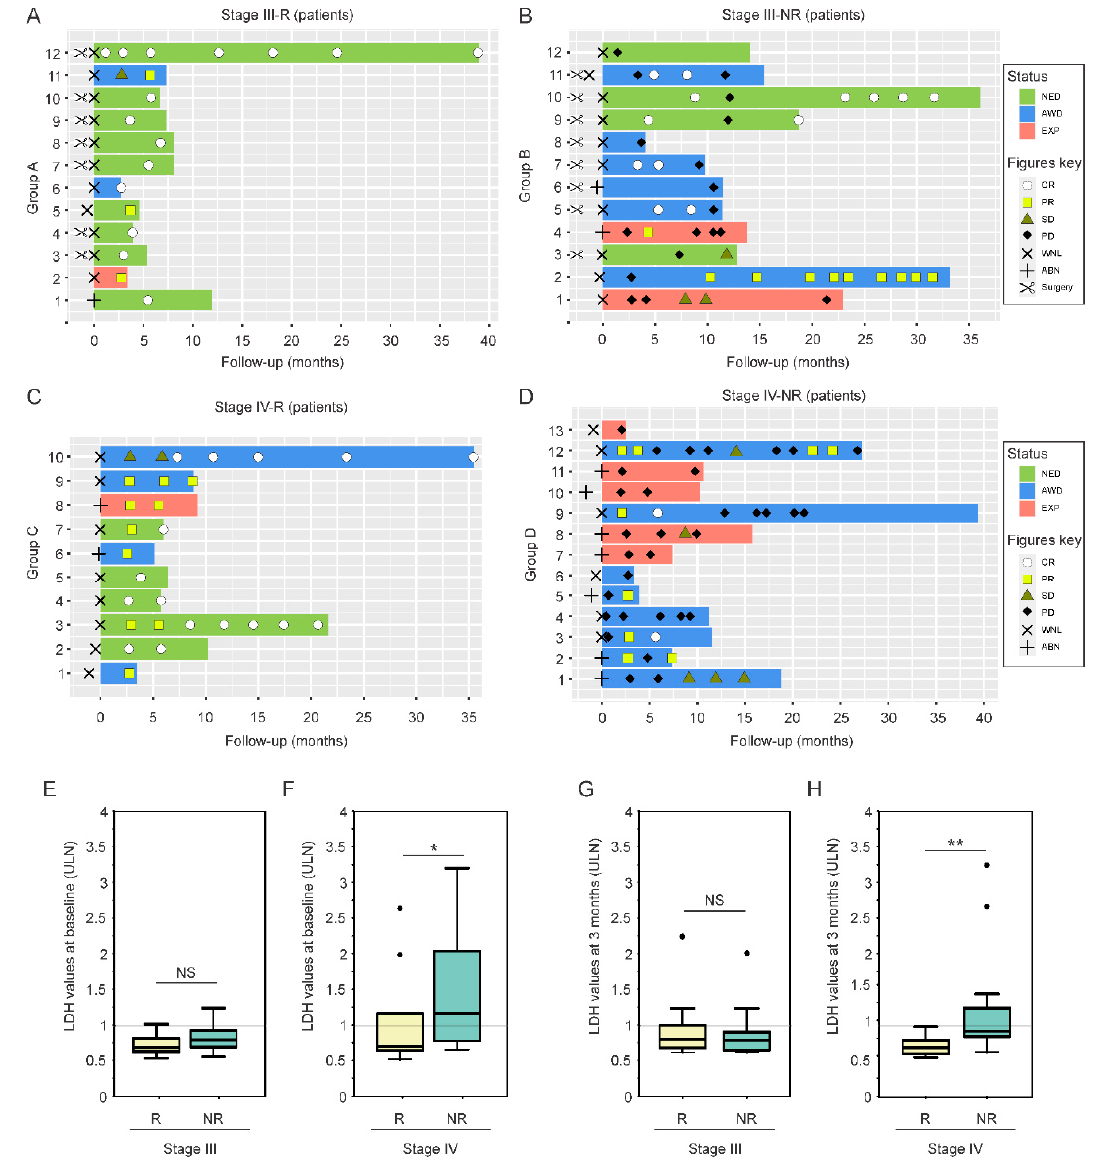
Figure 1. Melanoma patients and LDH assessment. ( A , B ) Swimmer plots showing disease status (NED, no evidence of disease; AWD, alive with disease; EXP, expired), RECIST 1.1 criteria (CR, complete response; PR, partial response; SD, stable disease; PD, progressive disease), surgery, and LDH levels (WNL, within normal; ABN, above normal) in stage III responder (Group A) ( A ) and non-responder (Group B) ( B ) melanoma patients. ( C , D ) Swimmer plots showing (NED, no evidence of disease; AWD, alive with disease; EXP, expired), RECIST 1.1 criteria (CR, complete response; PR, partial response; SD, stable disease; PD, progressive disease), surgery, and LDH levels (WNL, within normal; ABN, above normal) in stage IV responder (Group C) ( C ) and non-responder (Group D) ( D ) melanoma patients. ( E ) Boxplot showing the LDH values (ULN, upper limit normal) at baseline in stage III responder and non-responder melanoma patients (NS, non-significant). ( F ) Boxplot showing the LDH values (ULN) at baseline in stage IV responder and non-responder melanoma patients (* p < 0.05). ( G ) Boxplot showing the LDH values (ULN) at three months follow-up in stage III responder and non-responder melanoma patients (NS, non-significant). ( H ) Boxplot showing the LDH values (ULN) at three months follow-up in stage IV responder and non-responder melanoma patients (** p < 0.01). Dots represent outliers in each condition.